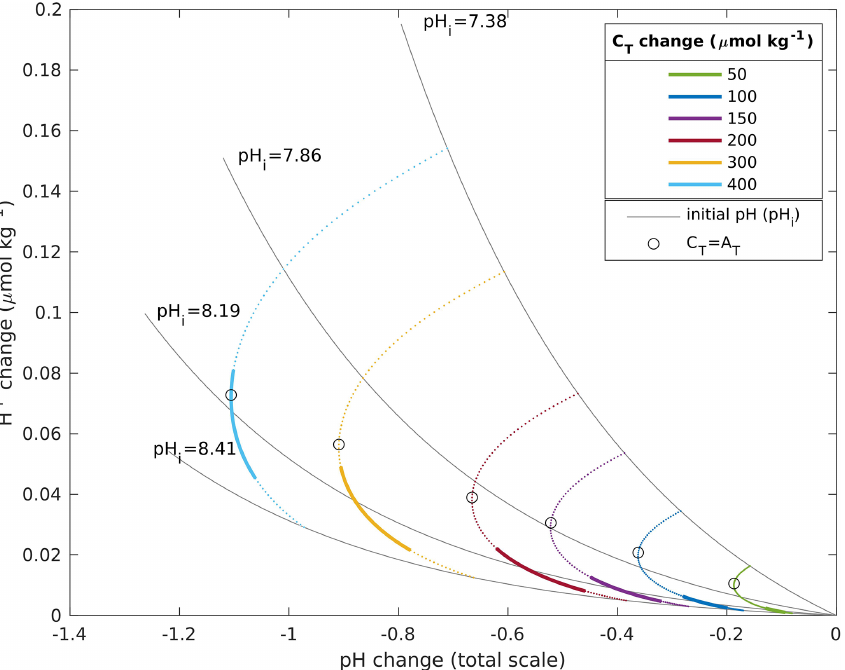
Figure 2. H + change plotted against pH change for six different increases in C T (colored lines) for a range of initial pH. The upper and lower ends of the colored lines represent an initial pH of 7.38 and 8.41, respectively. The bold part of the lines represents the pH range in the Nordic Seas’ surface water in the GLODAPv2 climatology. The circles are plotted at the initial pH, where the initial and final C T over the A T ratio are centered around 1.